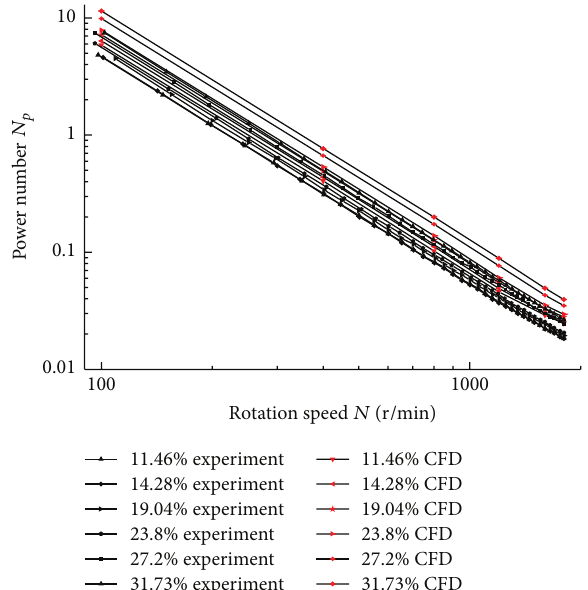
Figure 6: Comparison of CFD and experimental results for unbleached kraft